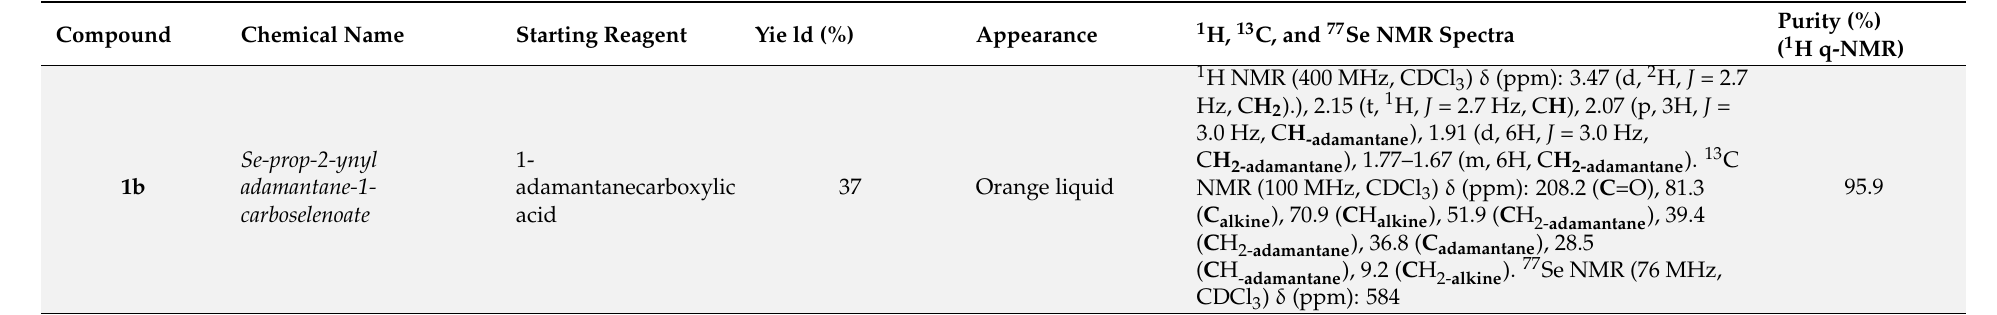
Table 2. Chemical name, starting reagent, yield (%), appearance, spectroscopical characterization by NMR and purity (%) of compounds from series b